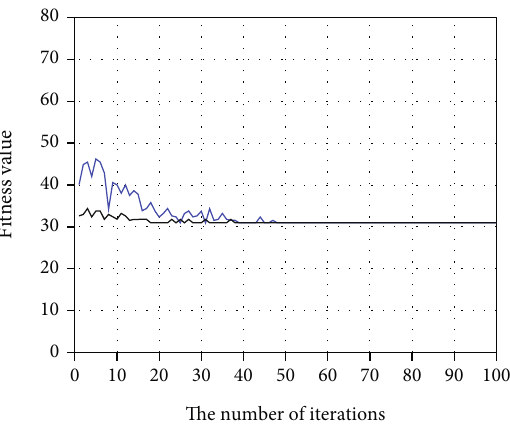
Figure 6: Comparison of minimum path cost and number of